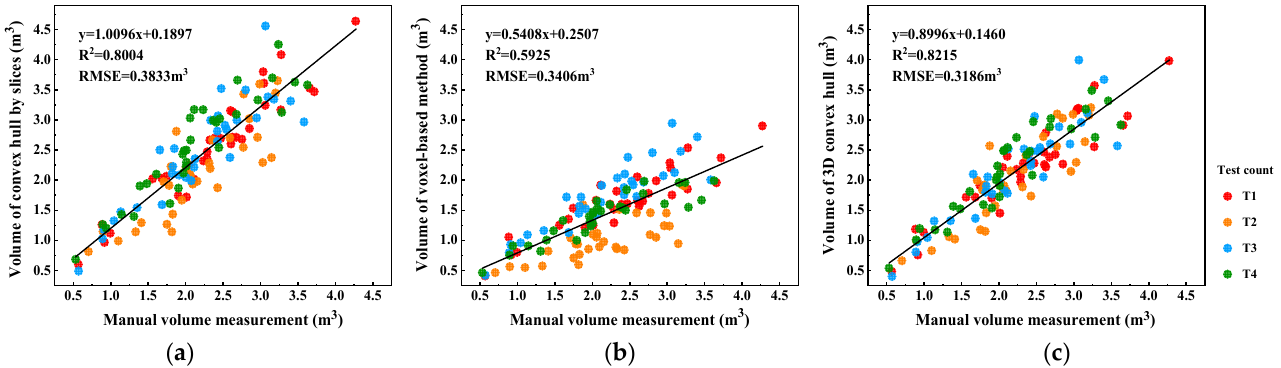
Figure 15. Scatter plot of volume calculated using three volume algorithms vs. manual calculation: ( a ) Convex hull by slices; ( b ) Voxel-based method; ( c ) 3D convex hull.